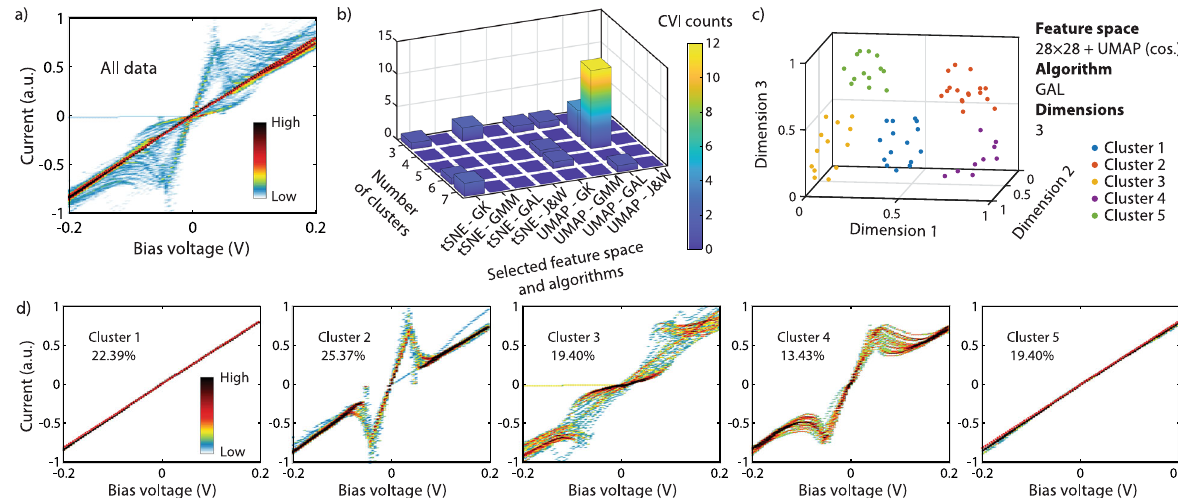
Fig. 4 Application of the method on current – voltage characteristics. a Experimental 2D current – voltage histogram based on 67 current – voltage characteristics recorded on a dihydroanthracene molecule 36,63,64 . b Determination of the most suited feature space, clustering algorithm and the optimal number of clusters using cluster validation indices (CVI). The feature space considered are 28 × 28 + t-distributed stochastic neighbor embedding (t-SNE) and 28 × 28 + uniform manifold approximation and projection (UMAP), both using a cosine (cos.) distance metric. The clustering algorithms considered are Gustafson – Kessel (GK), Gaussian mixed model (GMM), graph average linkage (GAL), spectral clustering following Jordan and Weiss (J&W), and Ordering Points To Identify the Clustering Structure (OPTICS). c Feature space constructed using the 28 × 28 + UMAP (cos.) and clustered using the GAL algorithm for fi ve clusters. d 2D current – voltage histogram of the data shown in ( a ), clustered according to the partitioning shown in ( c